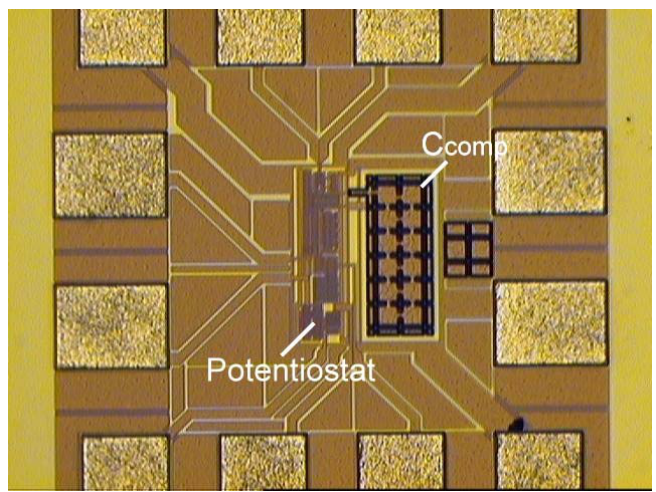
Figure 10. Photomicrograph of single-ended